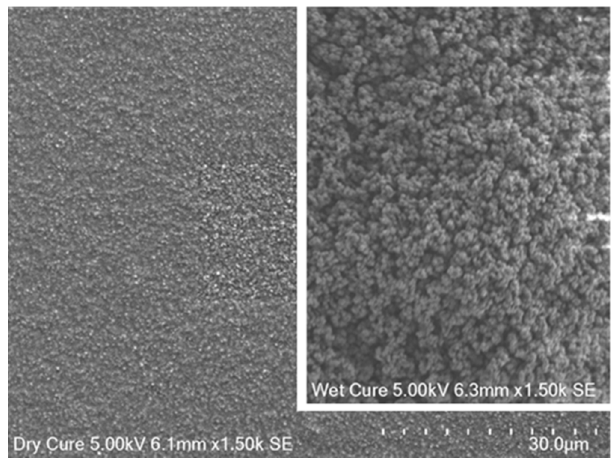
Figure 1. Surfaces of air-cured and pH 7-cured super-glue (inset), at the same